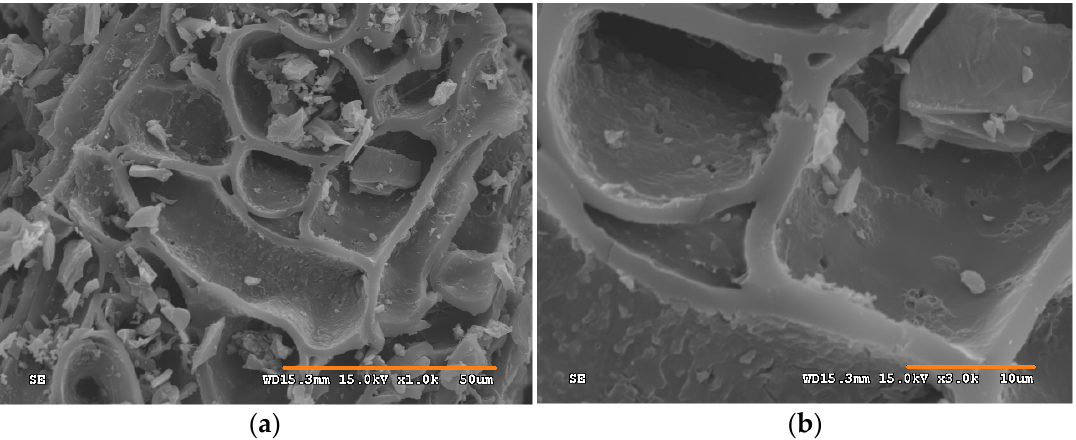
Figure 3. SEM images (( a ) Left: ×1000; ( b ) Right: ×3000) of resulting AC (WCH-AC).